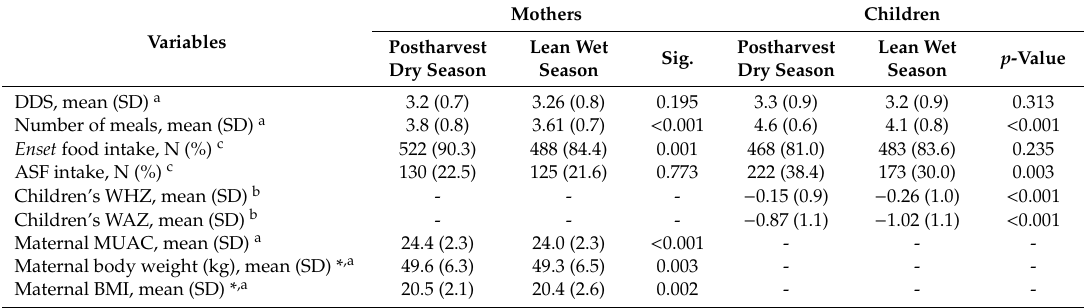
Table 4. Comparison of dietary diversity and anthropometric status of MCP between postharvest dry and lean wet seasons (N = 578), January–June 2017.